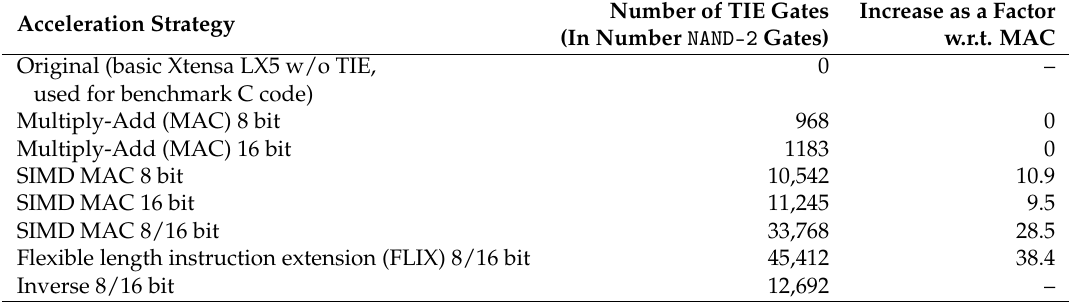
Table 1. Die size evaluation: Number (count) of NAND-2 equivalent gates for 8-bit operands in the Tensilica Instruction-Set Extensions (TIEs) for the different hardware acceleration strategies. The right-most column reports the gate counts of the SIMD and FLIX strategies as multiplicative factors with respect to the gate counts of the MAC strategy (the 8/16-bit SIMD and FLIX strategies consider the 16-bit MAC as corresponding